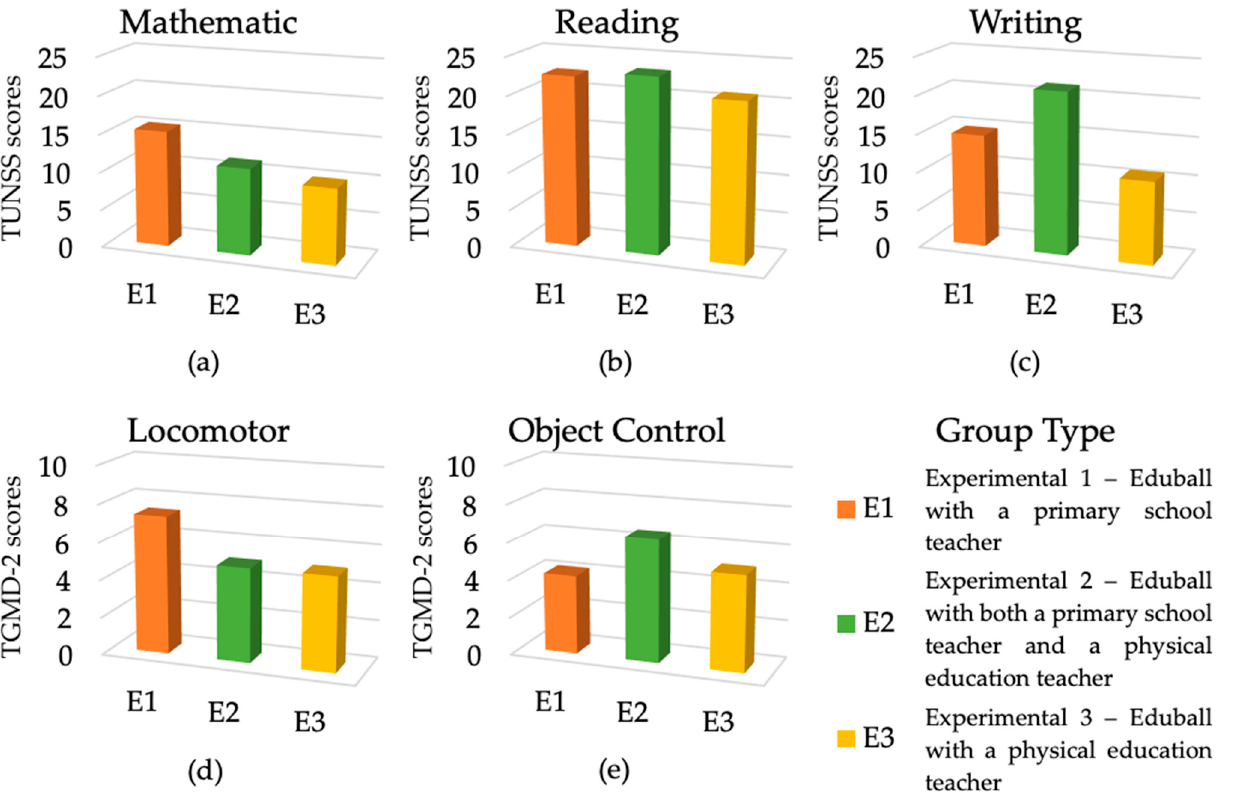
Figure 6. Results of the experiment in terms of cognitive and motor skills divided into three groups (Eduball 1 vs. Eduball 2 vs. Eduball 3) and expressed as difference scores. ( a ) The results of the two groups in terms of mathematical skills; ( b ) the results of the two groups in terms of reading skills; ( c ) the results of the two groups in terms of writing skills; ( d ) the results of the two groups in terms of total locomotor skills; ( e ) the results of the two groups in terms of total object control skills. Zero (“0”) indicates the pre-test baseline.